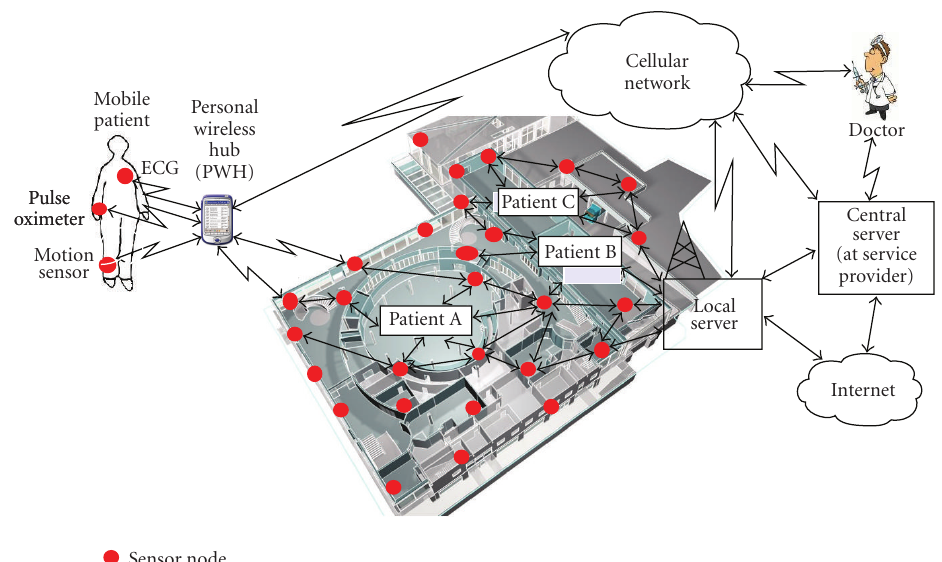
Figure 1: Wireless health monitoring in a smart